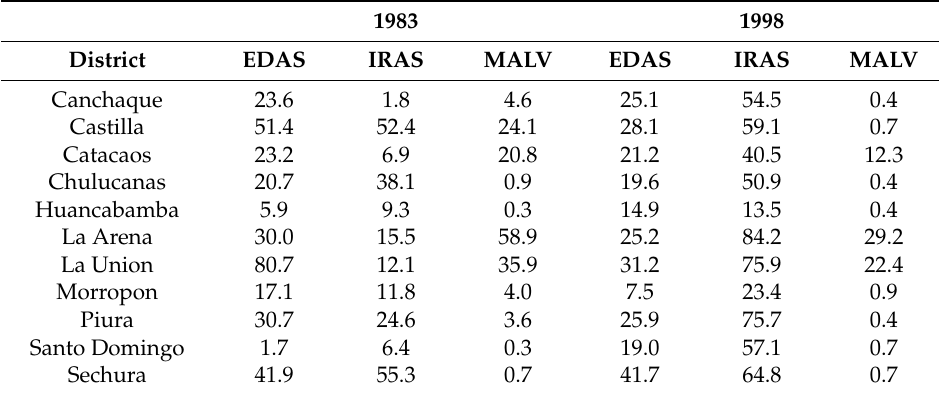
Table A6. Disease incidence data (per 1000 population) for ecosyndemic index construction and comparison between El Niño years, 1983 and